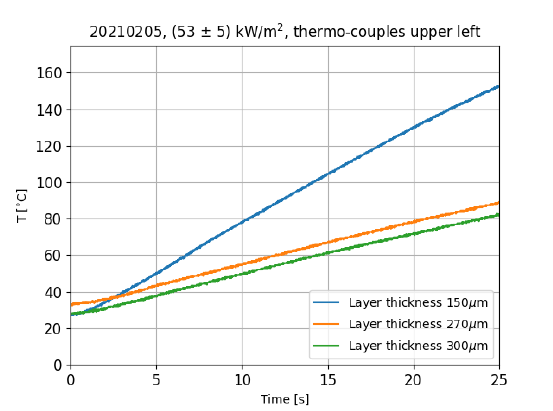
error of 10%. Having found the absorbed fractions in situ, the sensors are calibrated and can be used to provide the incident surface power density from the measured heating rate. At modest temperature linear scaling can be used but at elevated temperatures the heating rate is no longer linear as radiation becomes important.